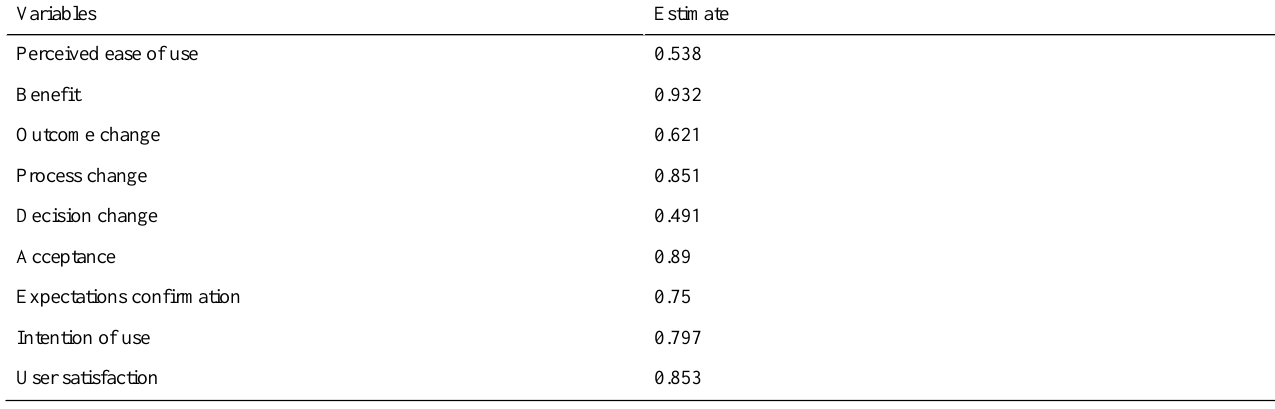
Table 5. Squared multiple correlations.